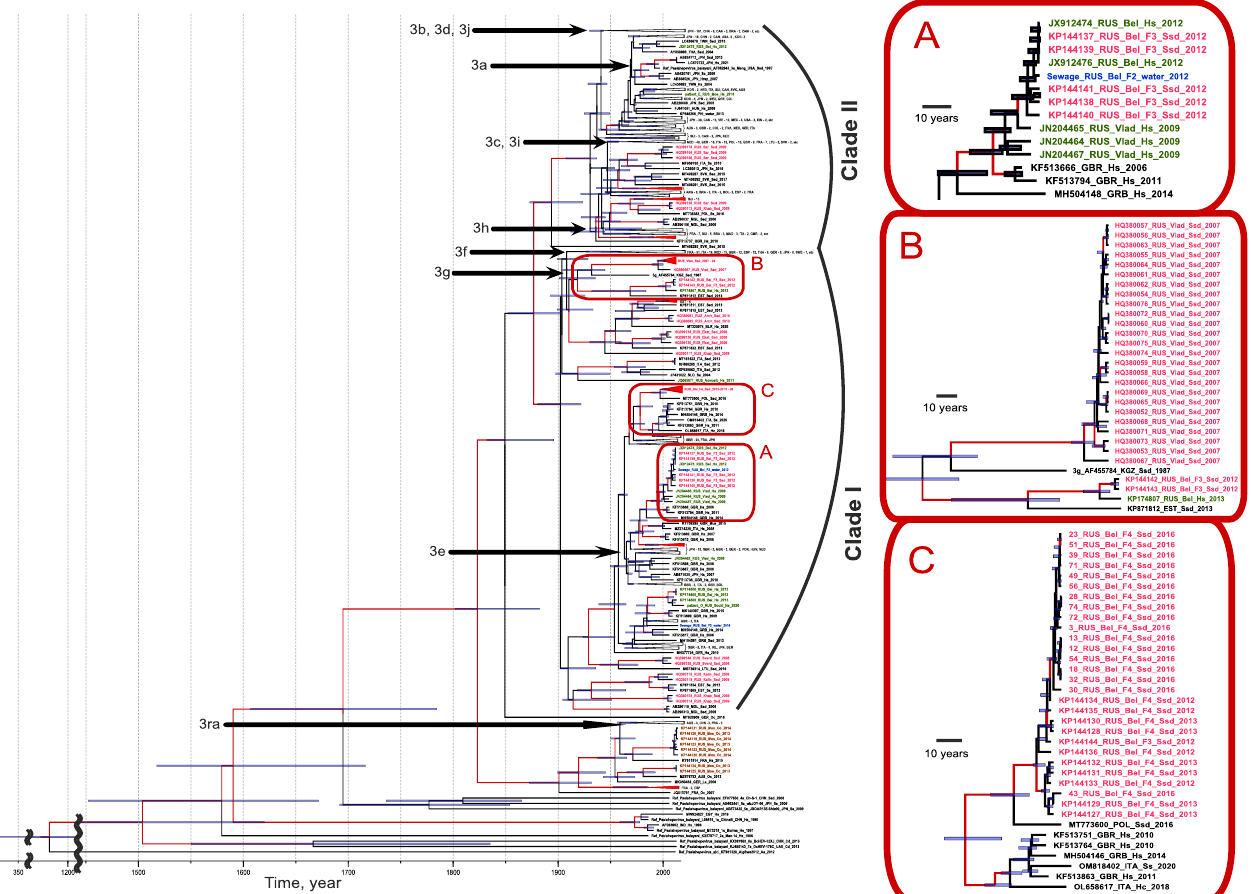
Figure 4. Bayesian phylogenetic tree based on 300 nt ORF-2 HEV sequences. The tree root was cut off to ensure the visibility of the modern parts of the tree. For each sequence, the number in the GenBank database, country (region), host organism, and the year of isolation are indicated. Host